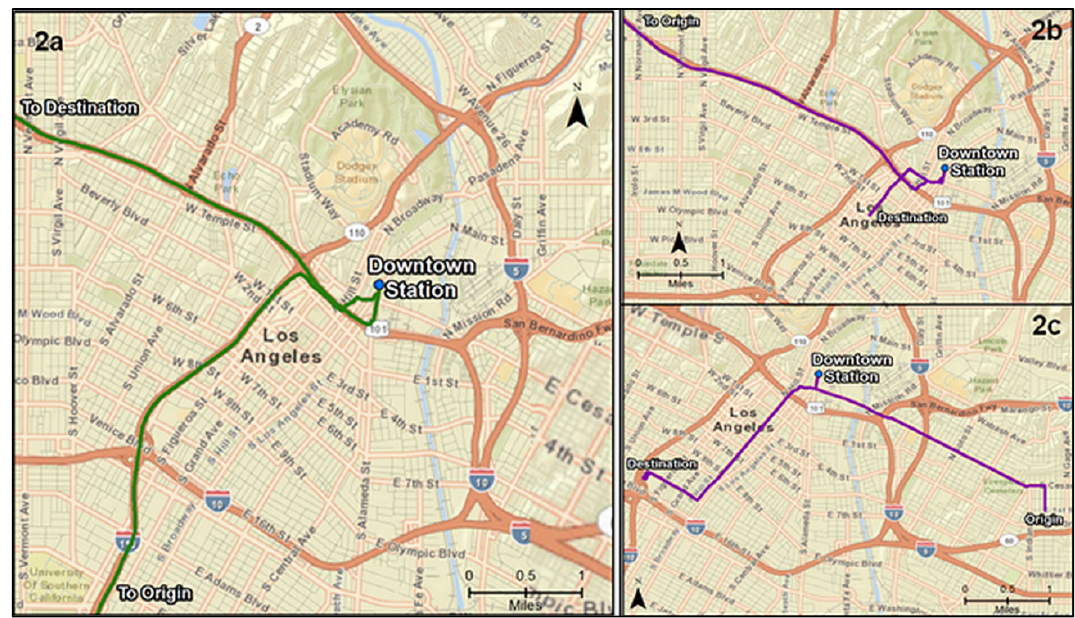
Figure 2. Examples of freeway trip type classifications. ( a ) Two freeway trip; ( b ) one freeway trip; ( c ) no freeway Trip.